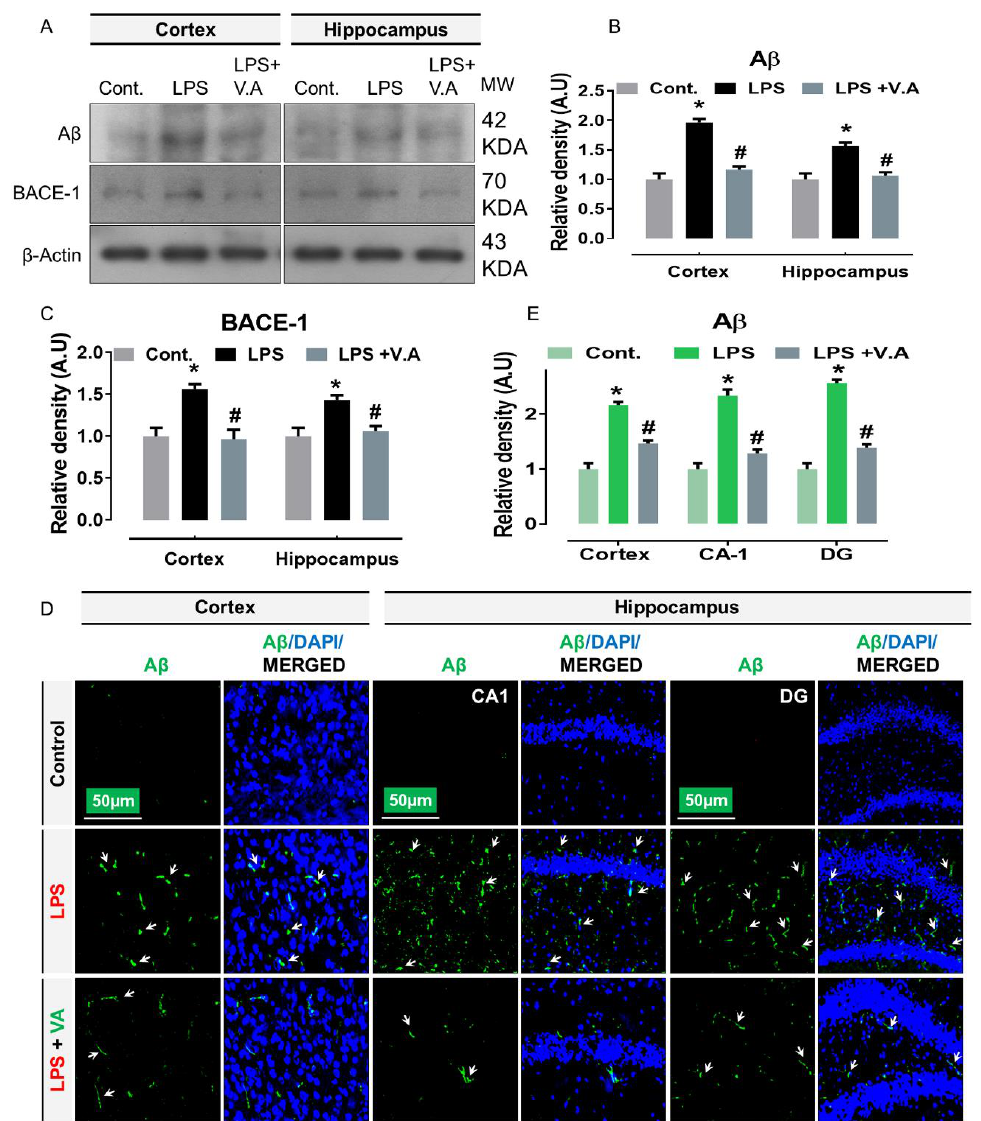
Figure 4. Vanillic acid treatment inhibits LPS-induced elevated protein expression of BACE-1 and β-amyloid (Aβ) in mice brain. ( A–C ) the western blot bands of BACE-1 and Aβ antibodies along with their relative histograms indicating their protein expression level in the cortex and hippocampus of mice brain. The western blot bands were cropped and quantified using ImageJ software, and the differences are shown in the histogram. The relative density values were expressed in comparison with control A.U. All values were taken as the mean ± SEM of three repeated/independent experiments for the respective indicated protein. As a loading control, an anti-β-actin antibody was used. n = 8 mice/group, and the number ( N ) of experiments performed = 3. ( D,E ) the representative photomicrographs of immunofluorescence staining represent the immunoreactivity of Aβ protein along with its relative histogram in different regions (cortex, CA1, and DG region) in various experimental brain groups (green, FITC; blue, DAPI). White small arrows indicated the desired signals of the tested antibody. The relative integrated density values were expressed in comparison with control in A.U. All values were taken as the means (± S.E.M) for the respective indicated proteins. For nucleus staining, DAPI (blue) was used. n = 8 mice/group, and the number ( N ) of experiments = N = 3. Magnification = 10×. Scale bar; cortices/DG hippocampal regions = 50 μm. Asterisk sign (*) indicated significant difference from the normal saline-treated (Cont.) group; hash sign (#) indicated significant difference from LPS-alone treated group; while the phi sign (Φ) indicated no significance from the normal saline-treated control group. Significance: * # = p ≤ 0.05.